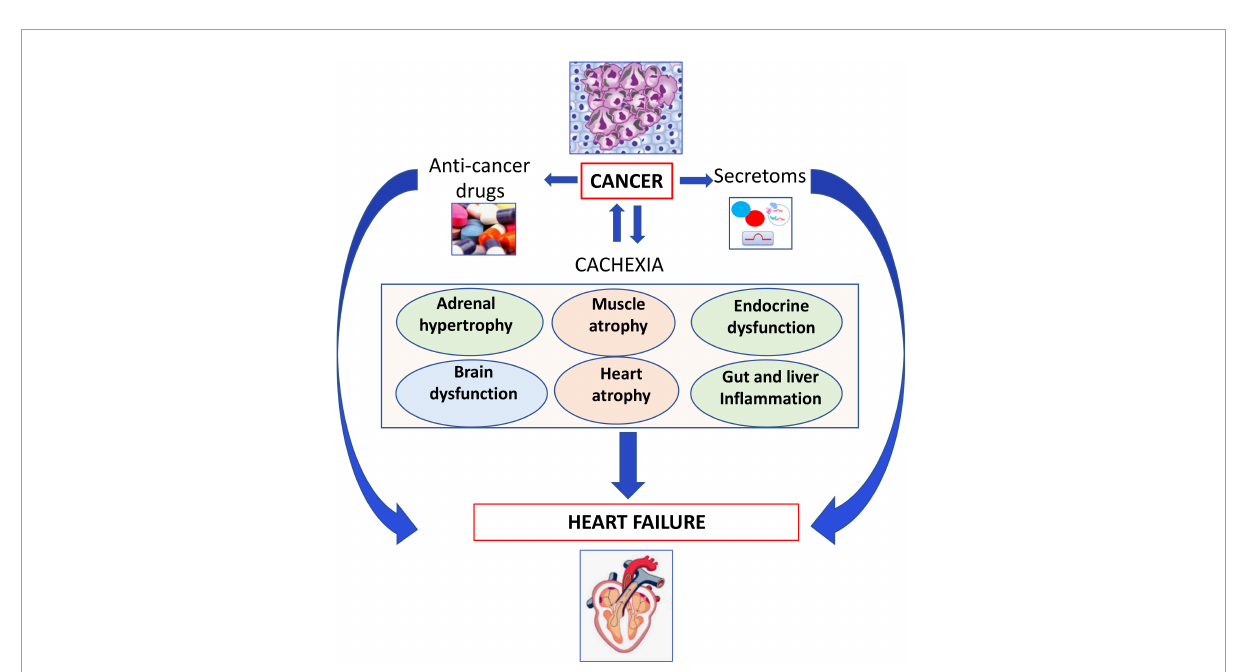
FIGURE3 Role of cachexia in development of heart failure. Cancer or anticancer drug-mediated cachexia may induce several organ dysfunctions leading to heart